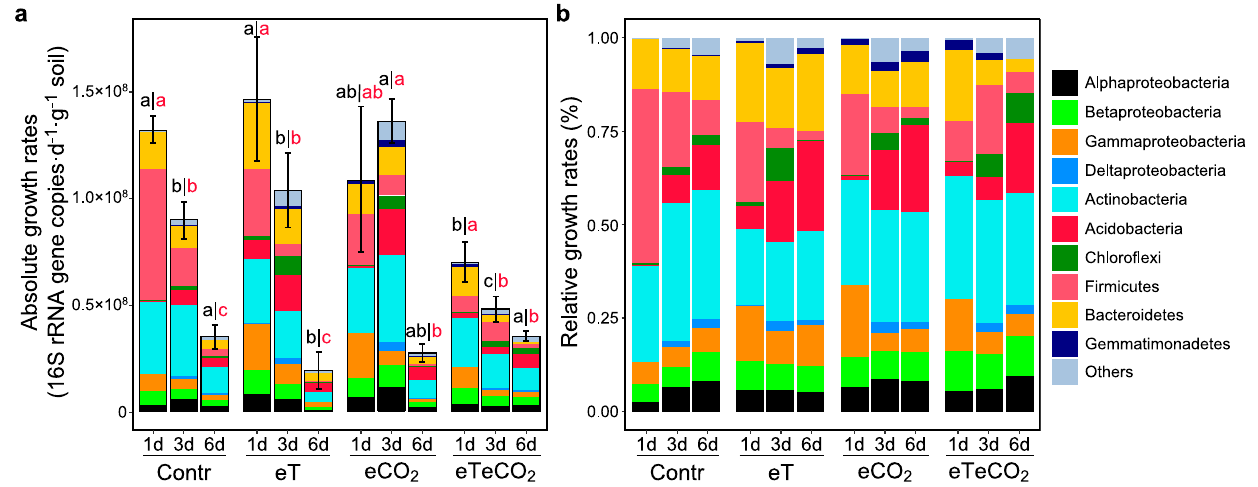
Fig. 2 | Growth dynamics ofthe bacterial communities in soils under different climate change scenarios after water addition. Absolute ( a ) and relative popu- lation growth rates ( b ) of bacterial phyla. Values were averaged across replicates ( n =3 biologically independent samples). Error bars: standard deviation (SD). The proportion of growth rate for each phylum (i.e., relative growth rate) was relativized by the total growth rate of the treatment. Bar color: bacterial phylum or class (10 of them are shown, accounting for > 93% of growth rates, and remaining phyla are